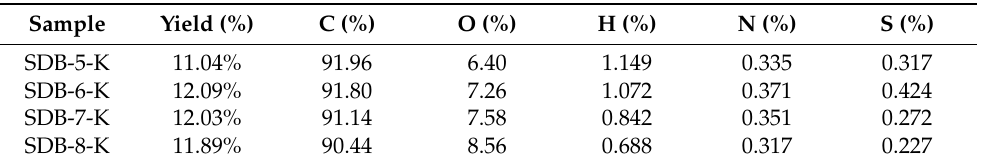
Table 2. The yield and the elemental analysis of SDBs-K.